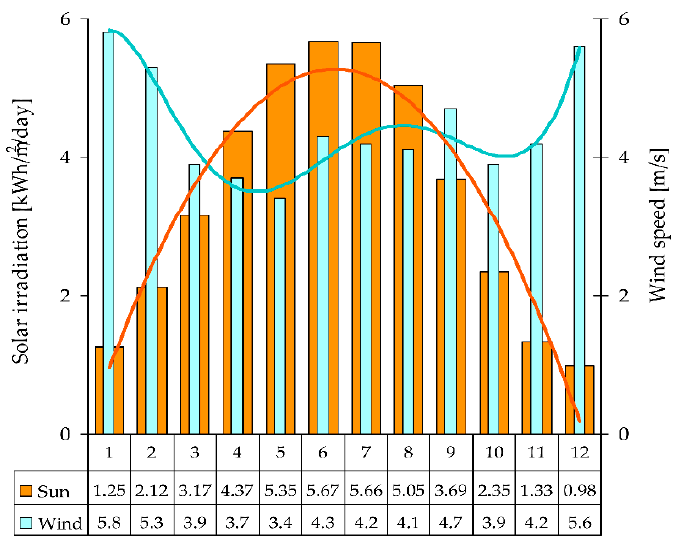
Figure 1. Renewable energy sources-solar (RES-S)—Global insolation profile. Monthly average values.